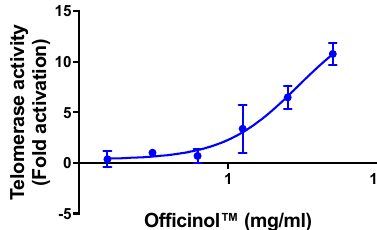
Figure 2. Concentration-dependent activation effect of Officinol™ on telomerase activity in HEK 293T cells. Graph on a logarithmic scale.